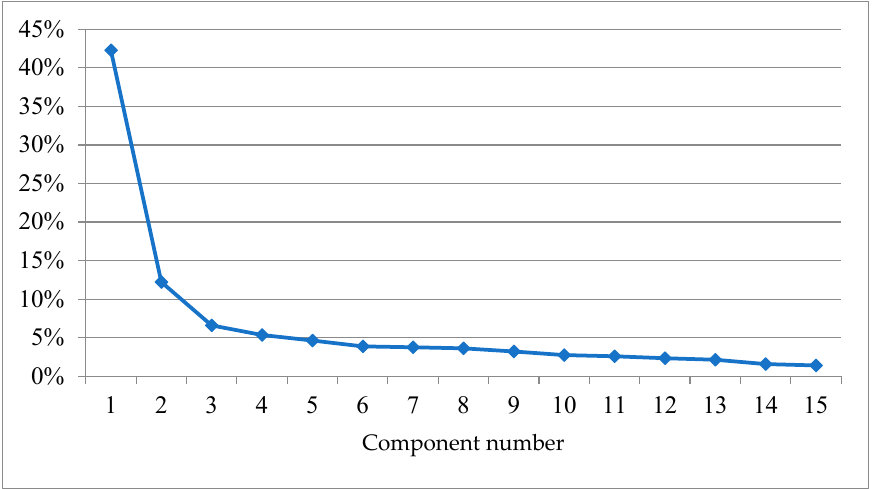
Figure 2. Extracted % of variance. Source: own calculations.